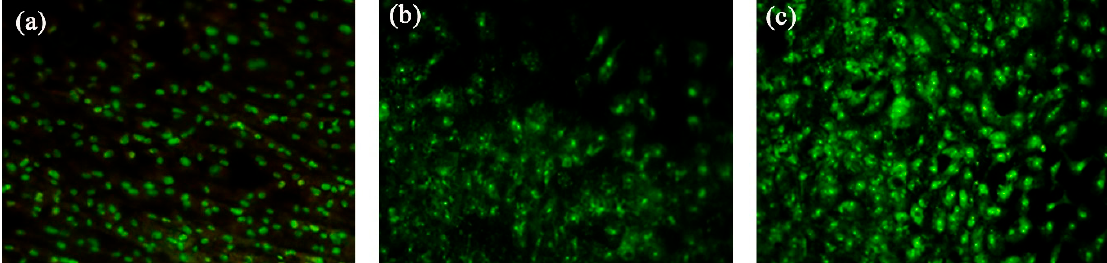
Figure 6. Fluorescent microscopy of adherent cells stained with acridine orange: ( a ) “AZ31”; ( b ) “dopa”; and ( c ) “dopa-O” after 24 h of cultivation time; (Magnification 100×).